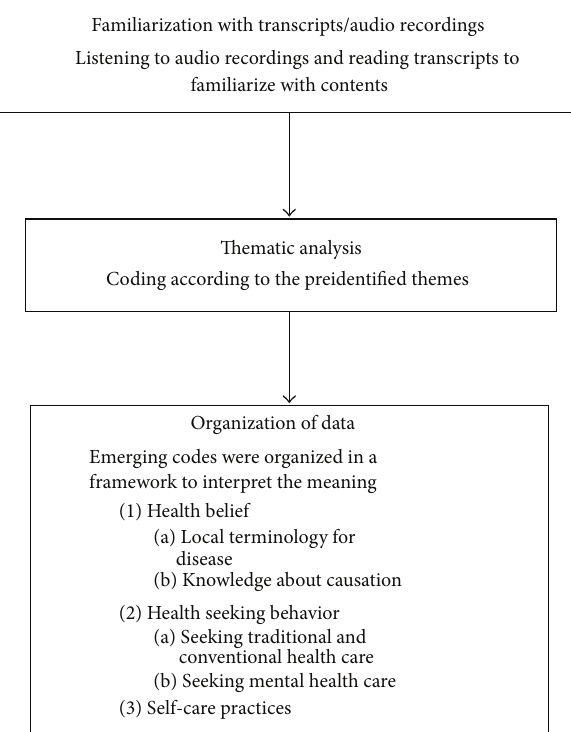
Figure 1: Data analysis